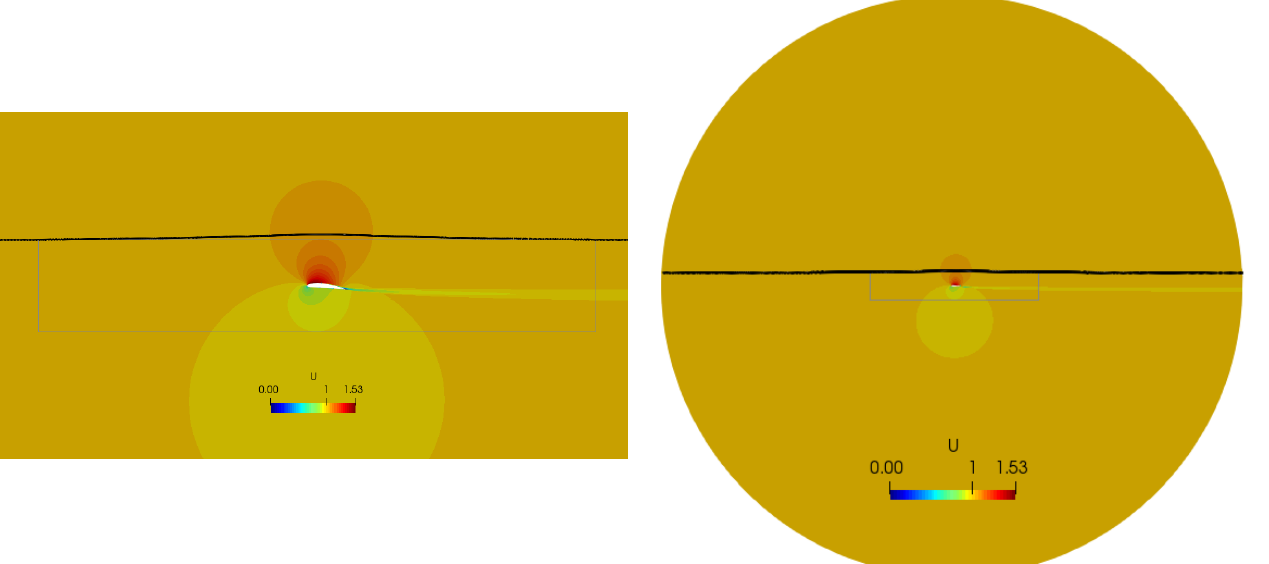
Figure 3. Left : Streamlines extracted from the unconfined simulation, at the location of the sidewalls in the wind tunnel test section. Right : Streamwise velocity distribution in the unconfined domain simulated via RANS. The box corresponds to the dimensions of the wind tunnel test